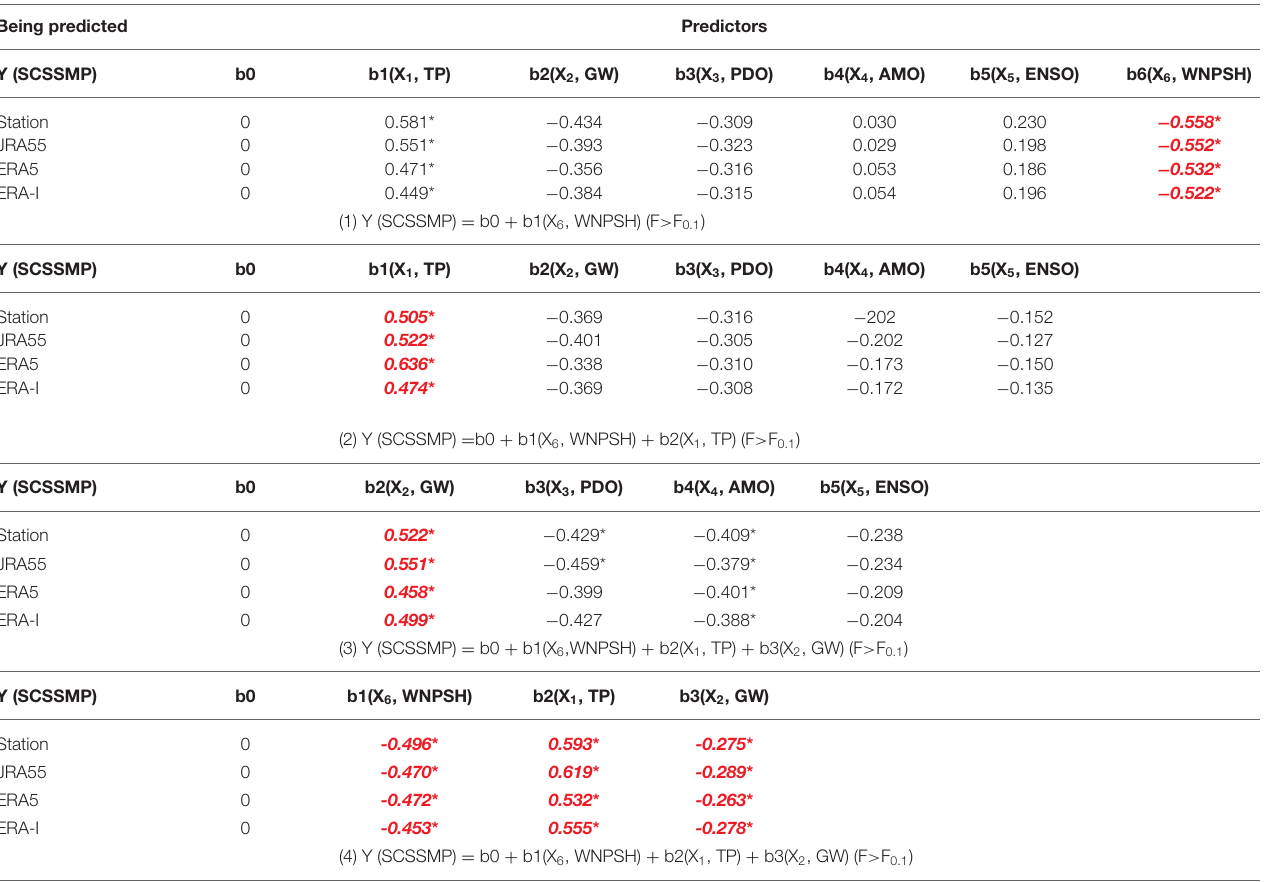
GW means the global warming. ( * indicate statistical significance above the 95% confidence level; The red italics indicate the important factors for the selection of this step; F > F 0.1 indicate the function are statistical significance above the 90% confidence level).